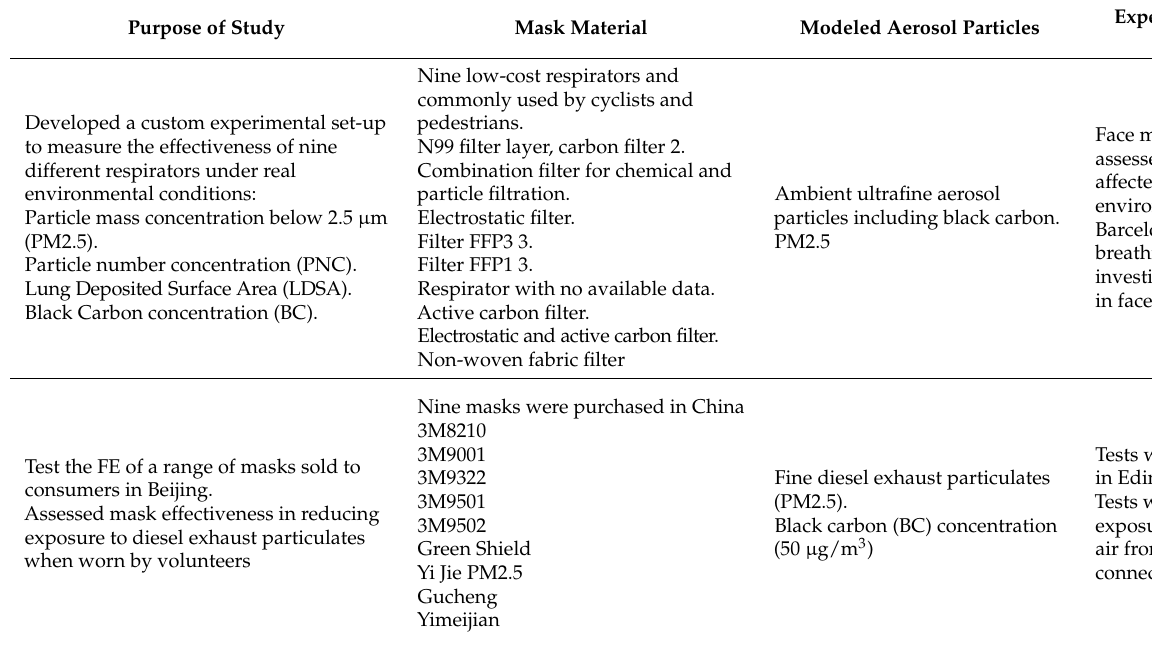
Table 5. Summary of face mask and respirator filtration experiments and testing practices using particles generated by incomplete or complete